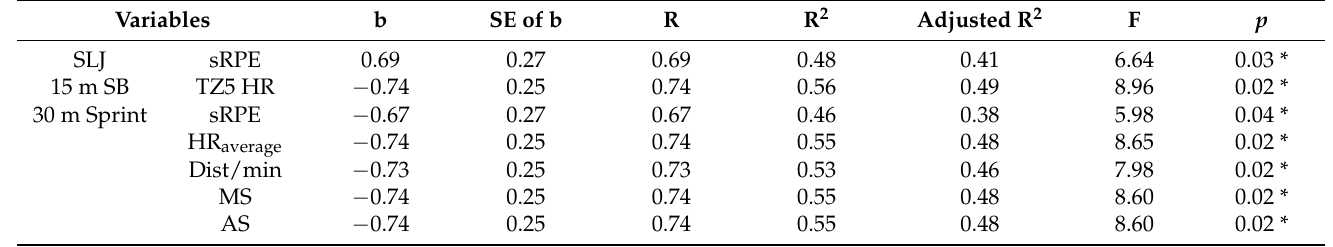
Table 9. Values of regression analysis explaining physical fitness assessment on performance variables and locomotor demands for non-selected futsal